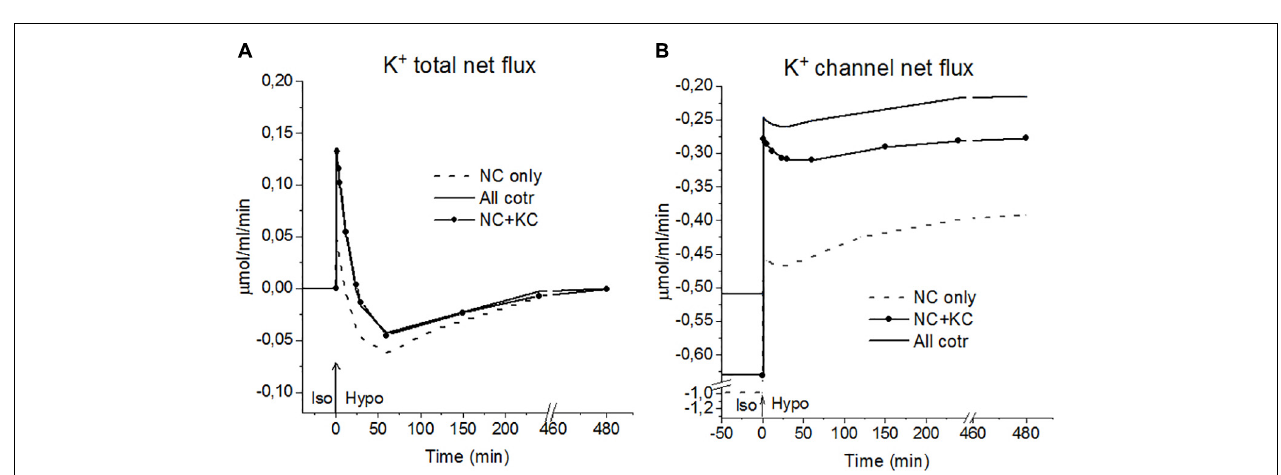
FIGURE 5 | K + fluxes during the Iso-Hypo transition, calculated for a system with different sets of cotransporters at the unchanged over time parameters as in U937 cells, equilibrated with standard RPMI medium. The arrows at t = 0 show the replacement of the standard 310 mOsm medium with a 160 mOsm hypoosmolar medium, obtained by decreasing the NaCl concentration by 75